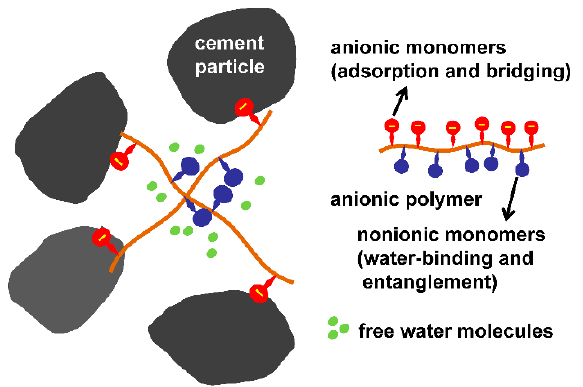
Figure 15. Schematic illustration of the effects of synthetic polymer VMAs on fresh cement pastes. Authorized reprint from [207].